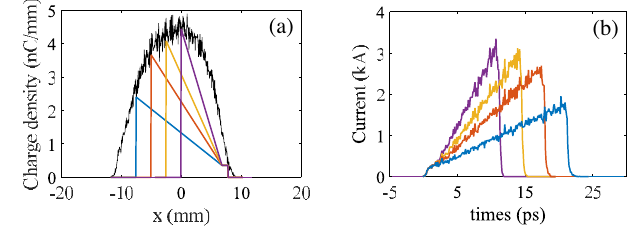
FIG. 9. (a) Horizontal profile at the mask location (black) and shaped horizontal profiles right after the mask (other colors). (b) Final current profiles corresponding to the different mask cut in (a).